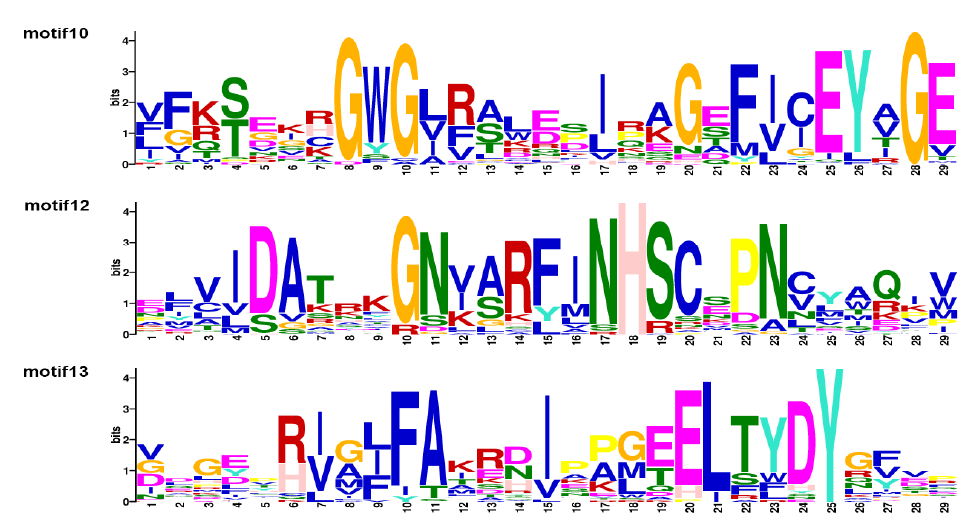
Figure 3. The sequence logos of conserved motifs in SUV gene family of B. rapa , B. oleracea and B. napus .